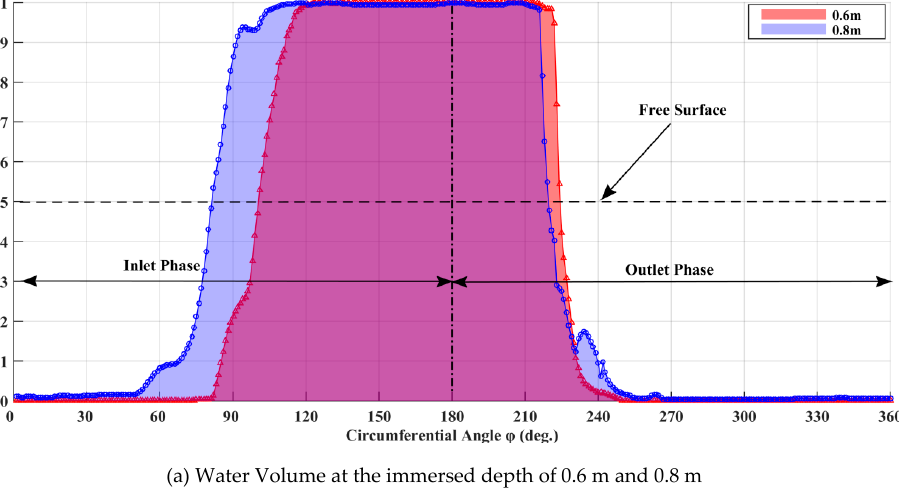
Figure 9. Water volume of different immersed depths at the wheel’s outer circumference.